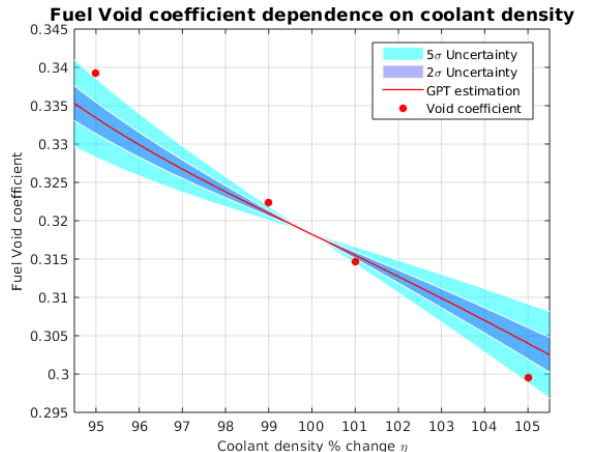
Figure 4: Fuel void coefficient